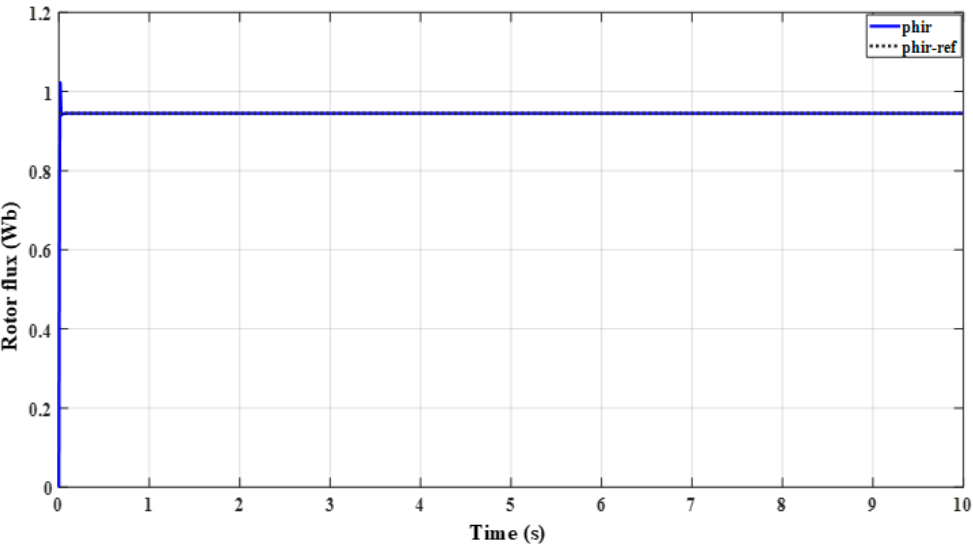
Figure 15. The testbed behaviour of the FOC algorithm for rotor flux response.